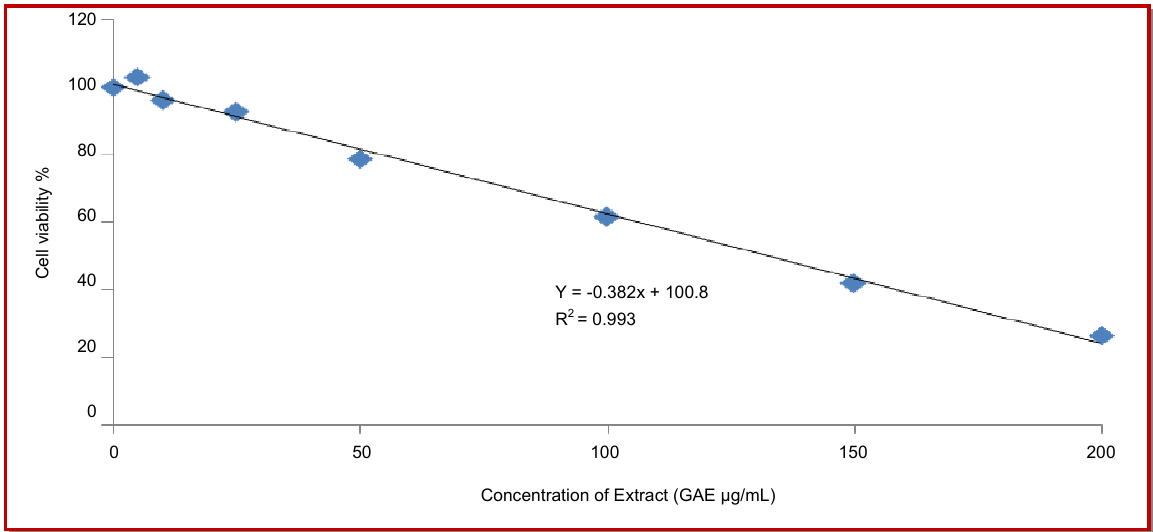
Figure 4: Linear relation between extract concentration in terms of GAE on U-2 osteosarcoma cell